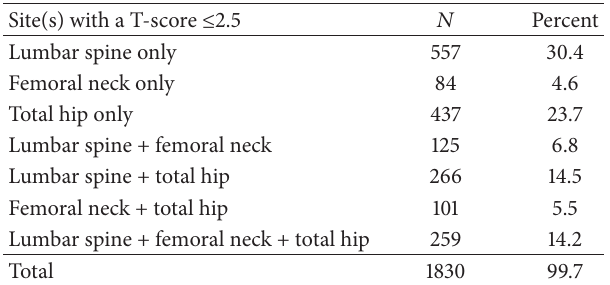
Table 2: Number of women with T-score at − 2.5 or below according to site.